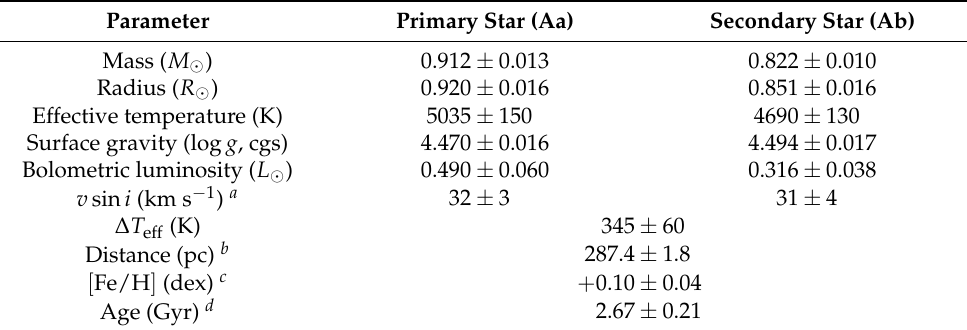
Table 1. Fundamental properties of the EPIC 219511354 components [11]. Parameter Primary Star (Aa) Secondary Star